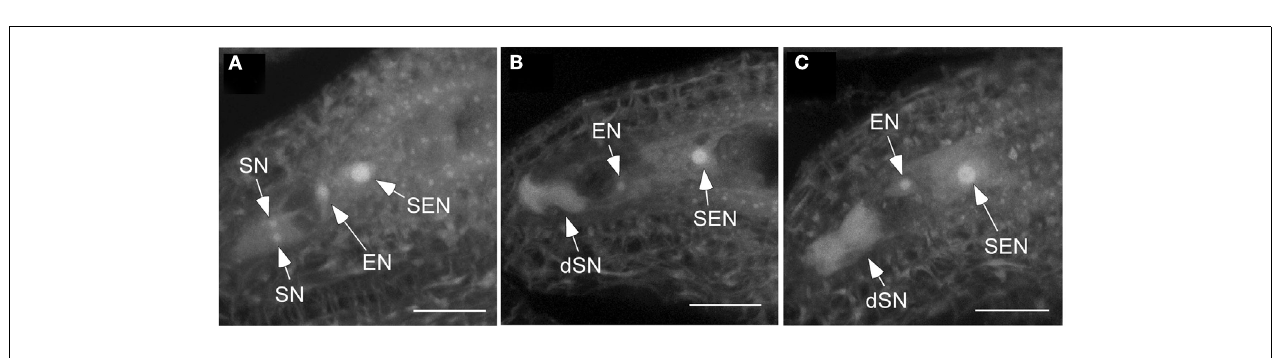
has degenerated synergid nucleus (dSN) as evident by increased autofluorescence and absence of a distinct synergid cell nuclei.Thirty percent of ovules of csld2 csld3 contained degenerated synergid cells. Images shown are a projection of fifteen 1.34 μ m confocal optical sections. Bars = 20 μ